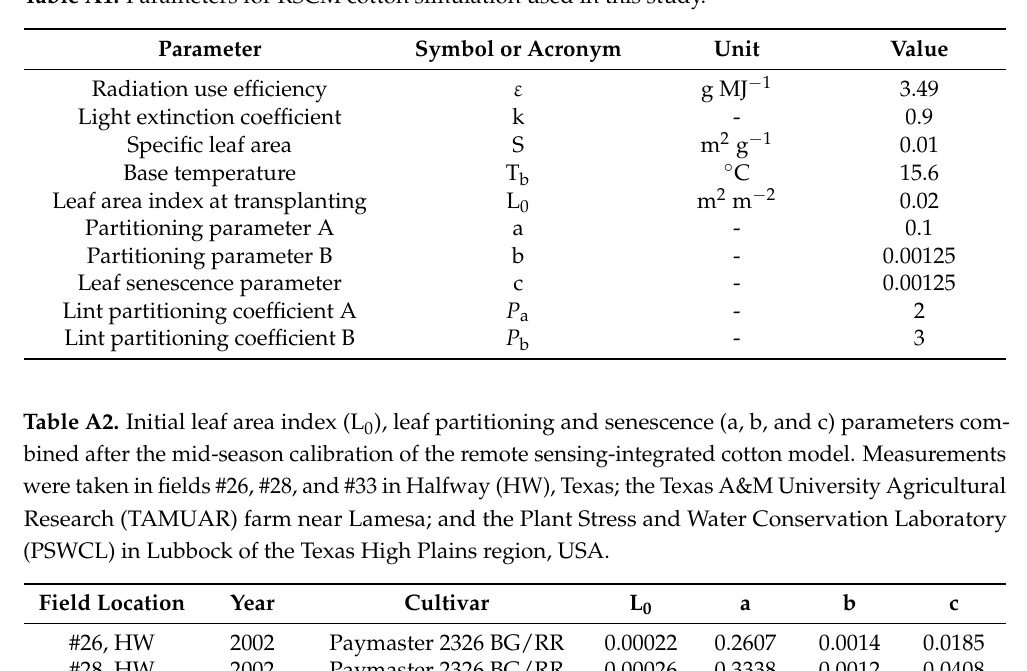
Table A1. Parameters for RSCM cotton simulation used in this study.